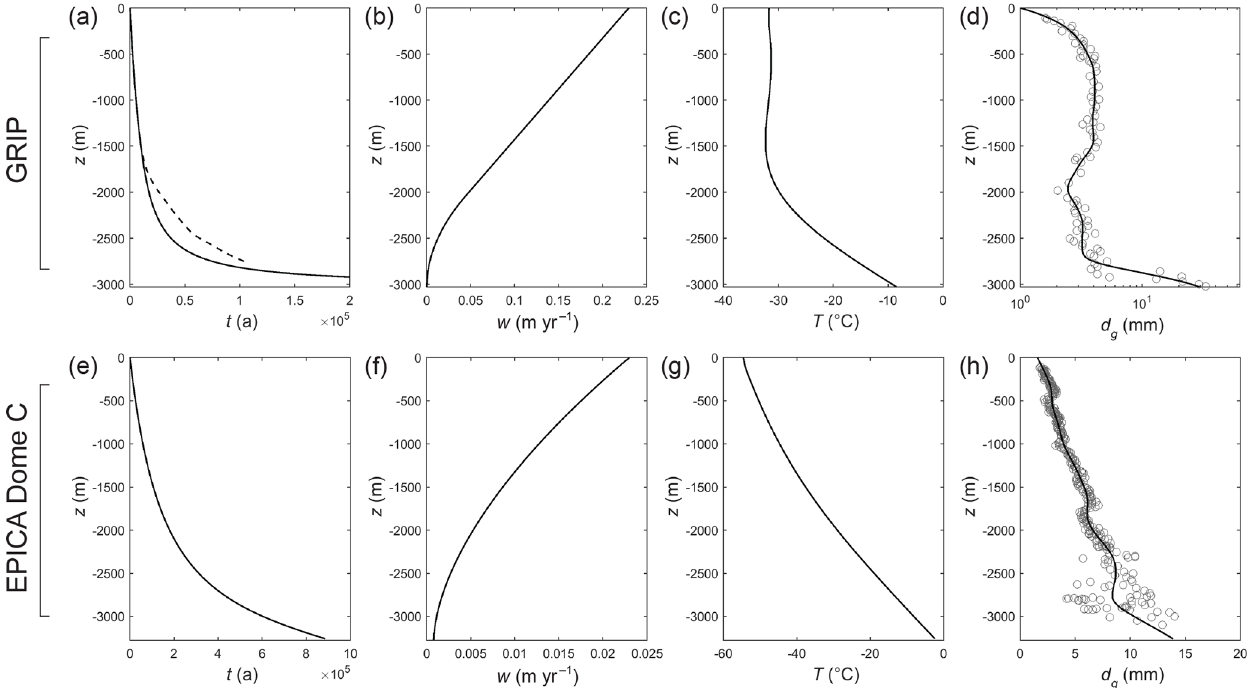
Figure 4. Ice-core background fields used in our signal evolution experiments. GRIP ice core: (a) – (d) . (a) Age–depth scale and (b) ice velocity from a Dansgaard–Johnsen model. Dashed line in (a) shows the GICC05 modelext timescale (Seierstad et al., 2014; Rasmussen et al., 2014). (c) Ice temperature from Johnsen et al. (1995). (d) Grain-size data from Thorsteinsson et al. (1997) and spline fit used